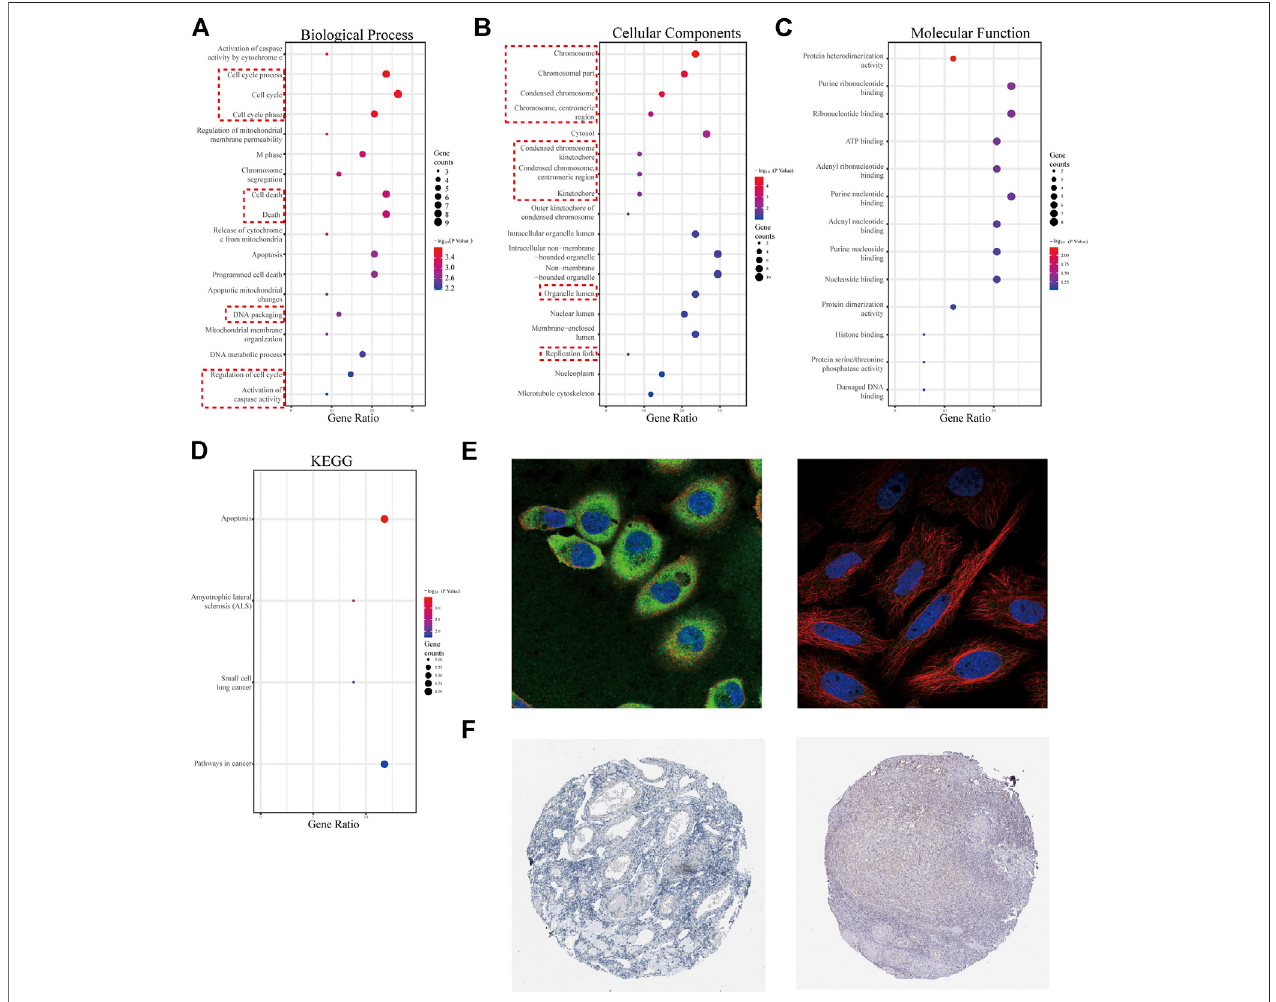
FIGURE7| GOanalysisfor34genesfromfourselectedmodulesandcharacteristicsofthepromisinghubgenes, SPTBN2 and BCL2L1 . (A) Biologicalprocessfor the 34 genes. (B) Cellular components for the 34 genes. (C) Molecular function for the 34 genes. (D) KEGG pathways enriched for the 34 genes. (E) Cellular localization from the cell atlas of the HPA database, with SPTNB2 localizing to the cytosol and cell junctions, stained in A-431 and MCF-7 cell lines (left) , and BCL2L1 localizing to mitochondria, stained in MCF-7 cell line (right) . (F) Decreased expression of SPTBN2 (left) and BCL2L1 (right) in normal ovarian tissue.